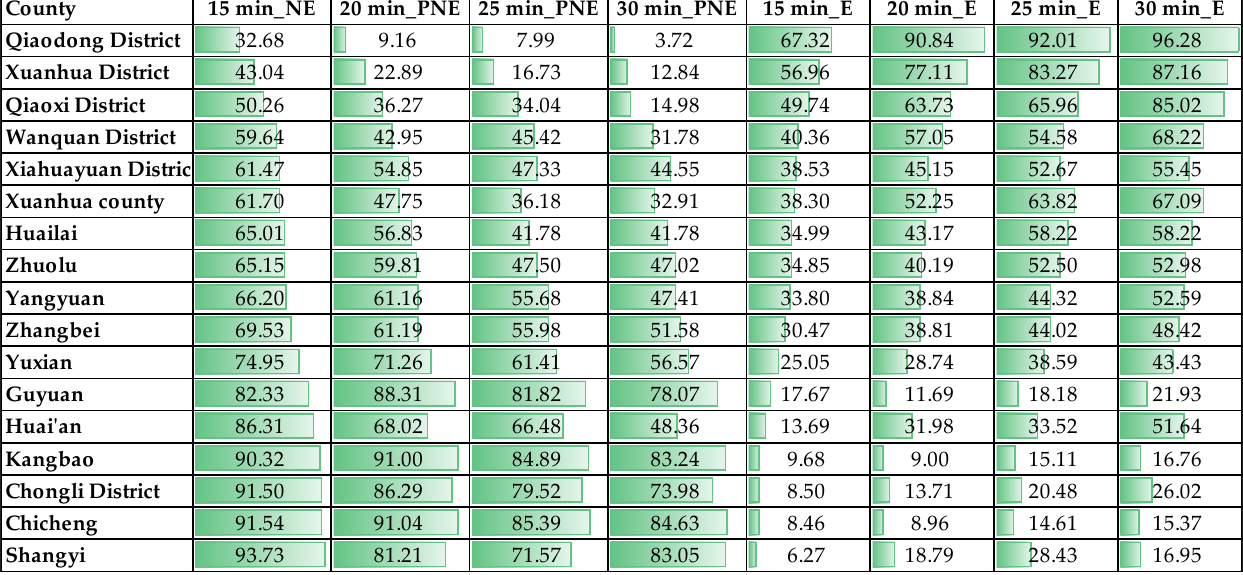
Figure 7. The ratio of primary children of non-equilibrium and equilibrium services at the county level (%) (Note: NE and E denote the primary children of non-equilibrium service and the primary children of equilibrium services, respectively).